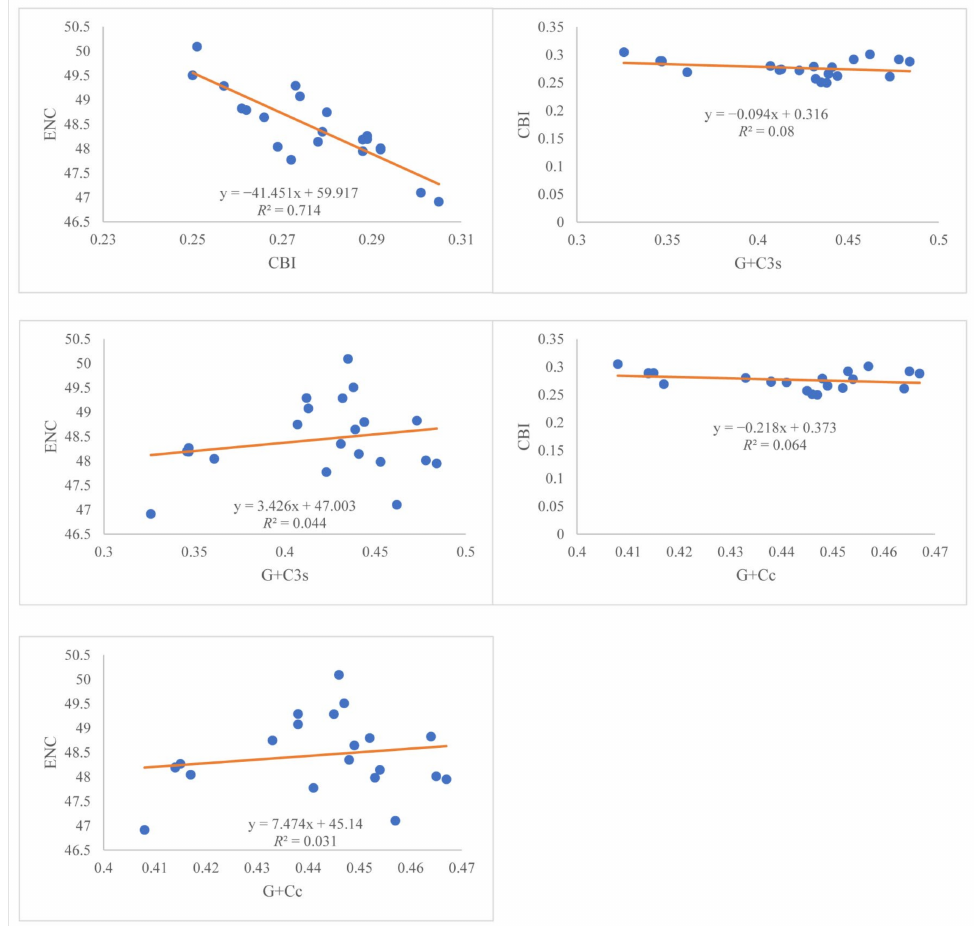
Figure 2. Evaluation of codon bias in mitogenomes of 17 Species of Rana . ENC, effective codon number. CBI, codon bias index. G + Cc, the content of G + C at all locations of the codon. G + C3s, G + C content of the third codon position.